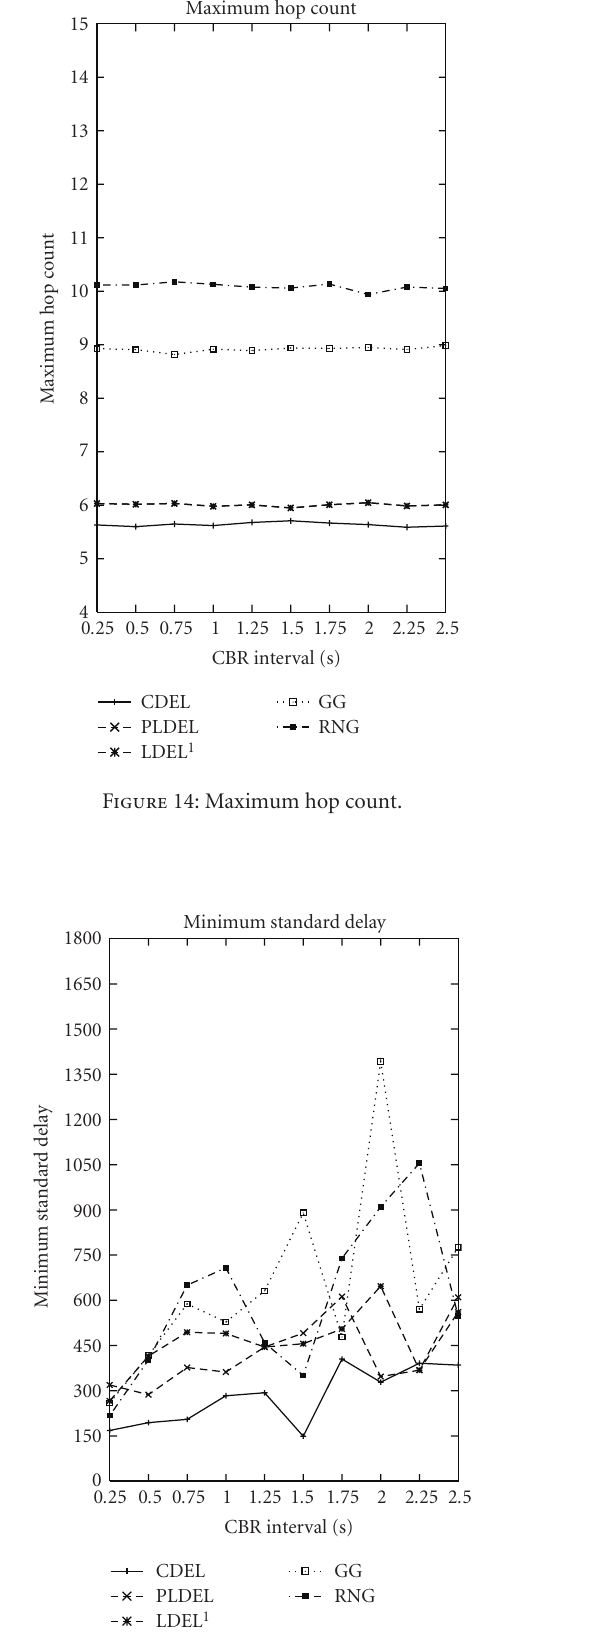
Figure 15: Minimum standard delay in μ sec.